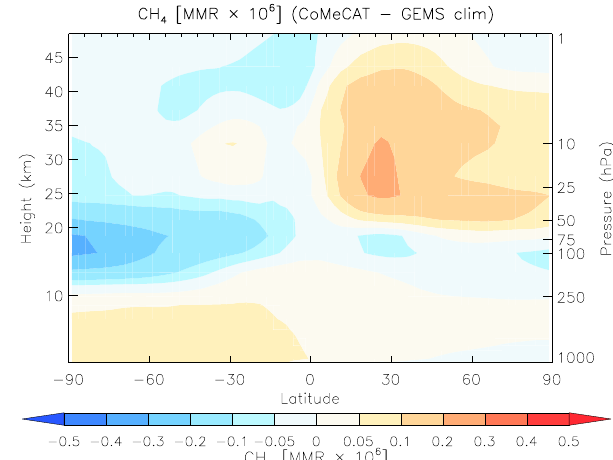
Fig. 13. Annually averaged cross section for the differences in the CH 4 concentrations (10 − 6 kgkg − 1 ) between the CoMeCAT dis- tribution and the ECMWF GEMS climatology; these differences correspond to the radiative effect (RE) shown in the lower panel of Fig. 12. Colour scale goes from most negative differences (dark blue) to most positive differences (dark